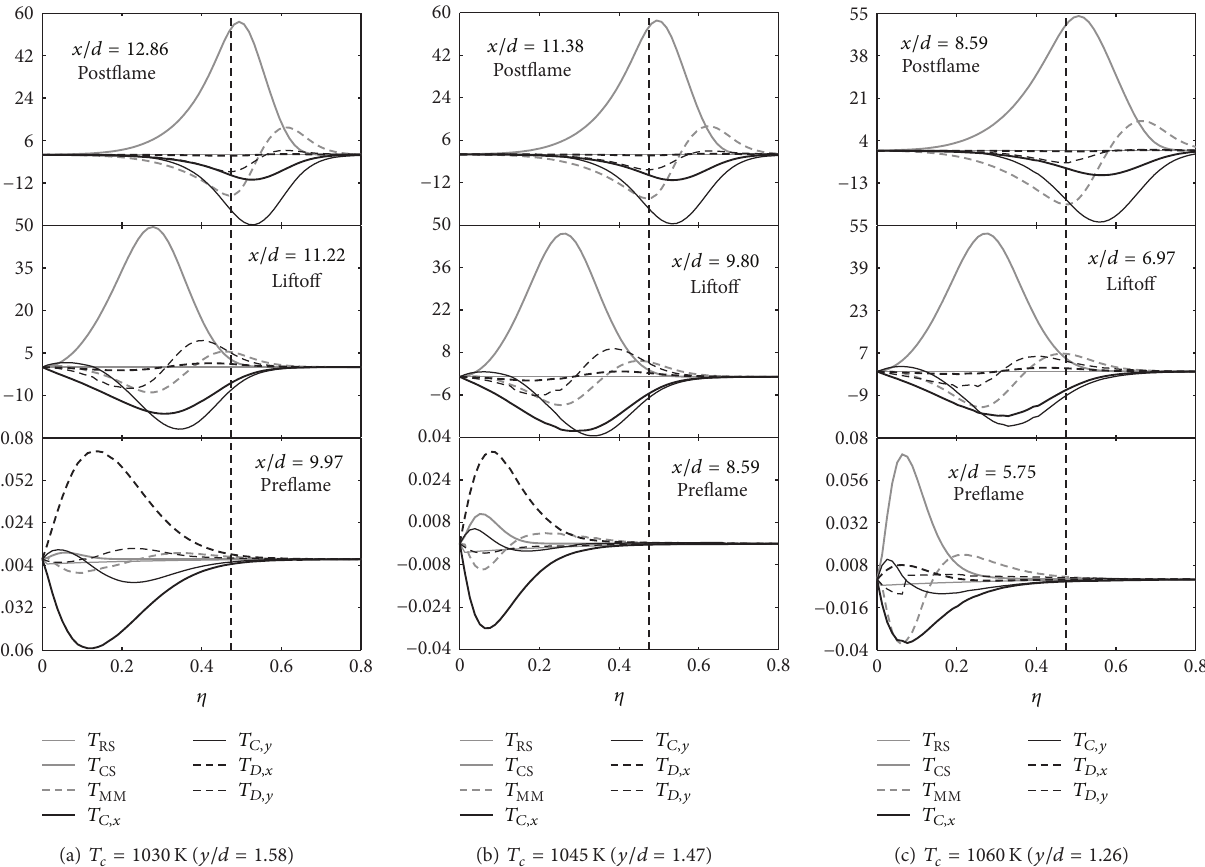
Figure 6: Transport budget of the steady-state 𝑄 𝑇 equation (r.h.s. terms of (2)) obtained using the CMC-PMF realisation for different coflow temperatures: (a) 𝑇 𝑐 = 1030 K ( 𝑦/𝑑 = 1 . 58), (b) 𝑇 𝑐 = 1045 K ( 𝑦/𝑑 = 1 . 47), and (c) 𝑇 𝑐 = 1060 K ( 𝑦/𝑑 = 1 . 26). 𝑇 : micromixing; 𝑇 𝐶,𝑥 : axial convection; 𝑇 𝐶,𝑦 : radial convection; 𝑇 𝐷,𝑥 : axial diffusion; 𝑇 𝐷,𝑦 : radial diffusion. The vertical chemical source; 𝑇 MM dashed line corresponds to the location of the stoichiometric mixture fraction. All terms are scaled down by a factor of 10 5 and the units are